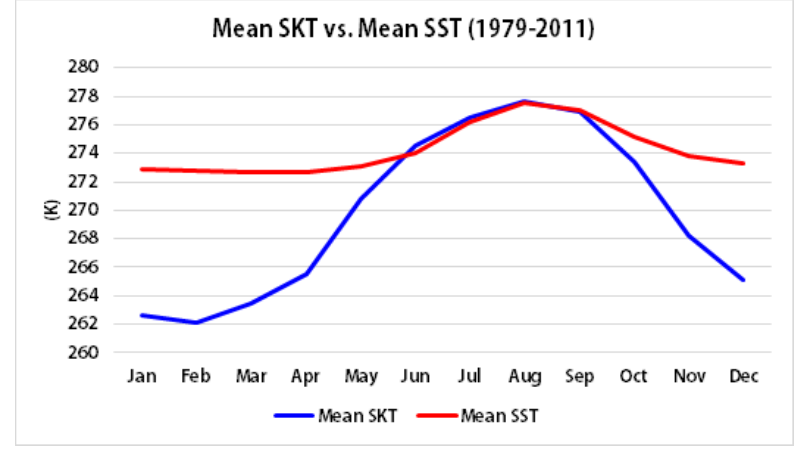
Figure 2. Monthly mean skin temperature (SKT) and sea surface temperature (SST) during 1979–2011. The values for the entire pixels were aggregated.